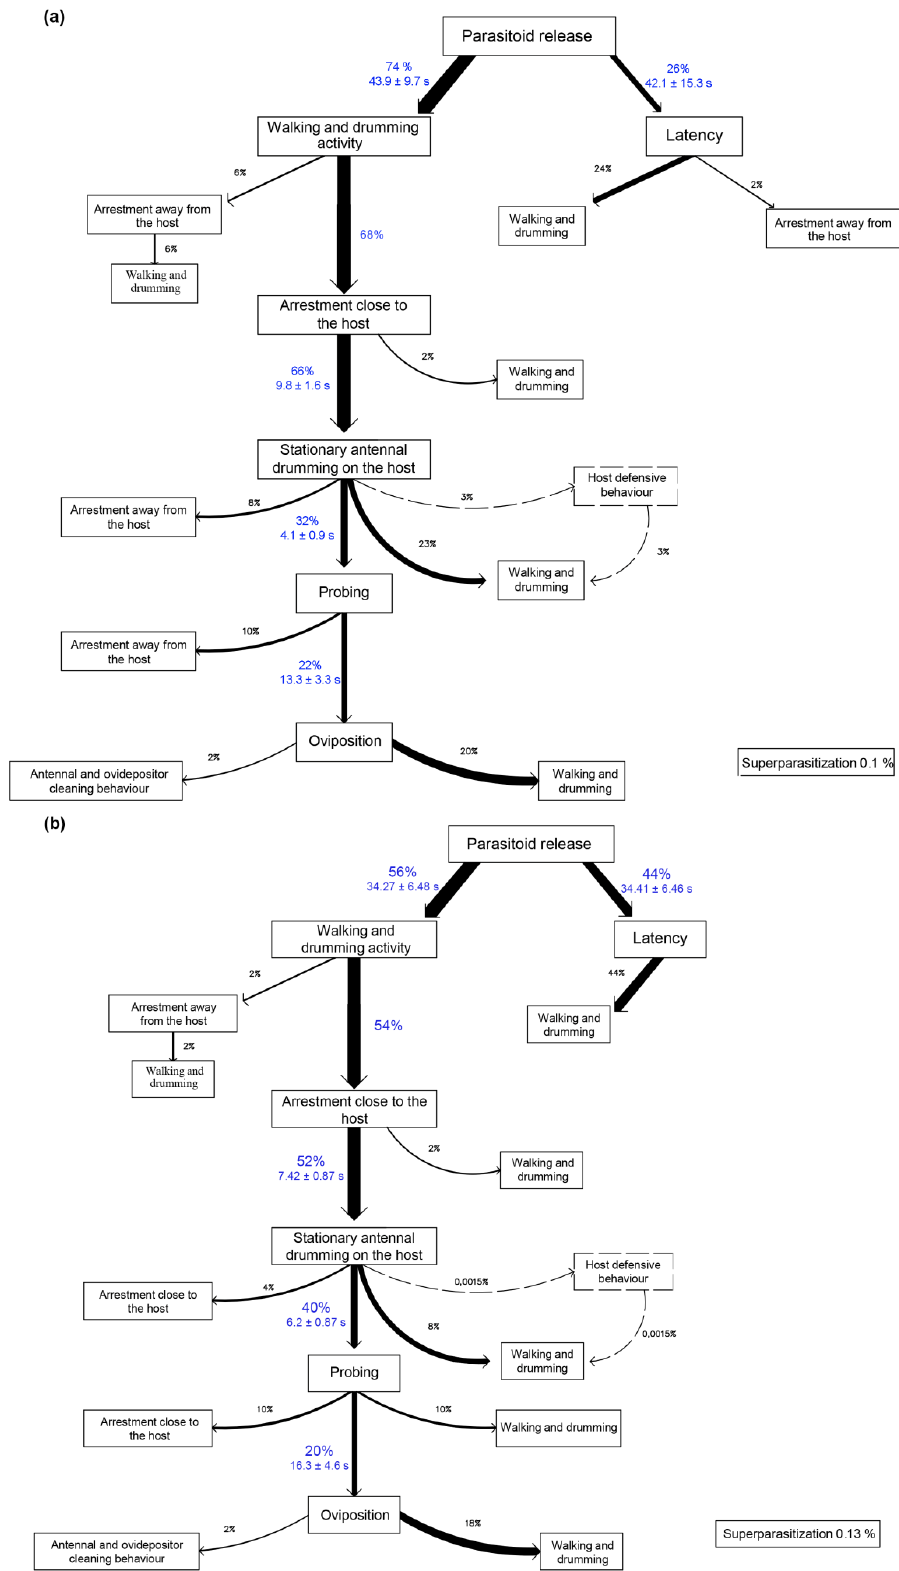
Figure 3. Quantitative analysis of behavioral displays performed by Anagyrus vladimiri parasitizing Pseudococcus comstocki ( a ) and Planococcus ficus ( b ). (% values indicate the percentage of individuals performing a given display out of the total number of individuals in the experiment; when it was possible to quantify it, the duration of each display is provided in seconds (s) (means ± SD); Superparasitism (%) of each host is provided in the lower right corner of each